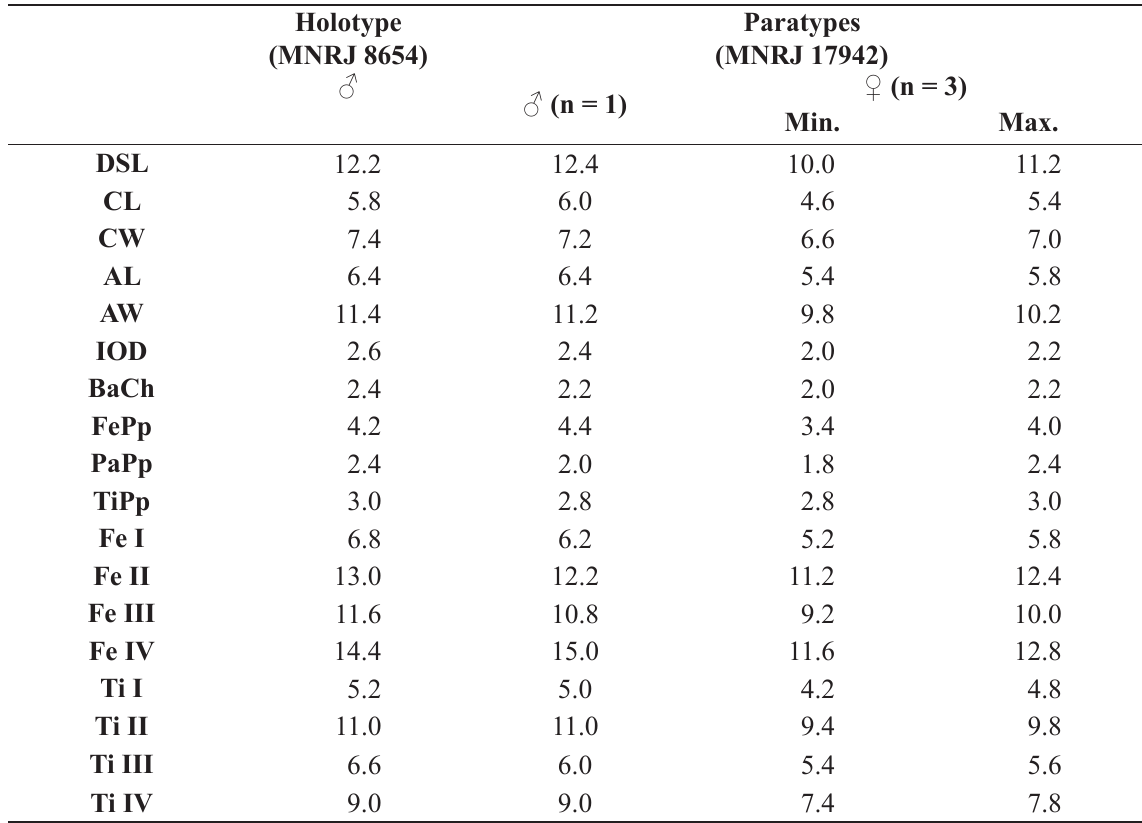
Table 3. Phalangodus cottus sp. nov., measurements of body and appendage, in